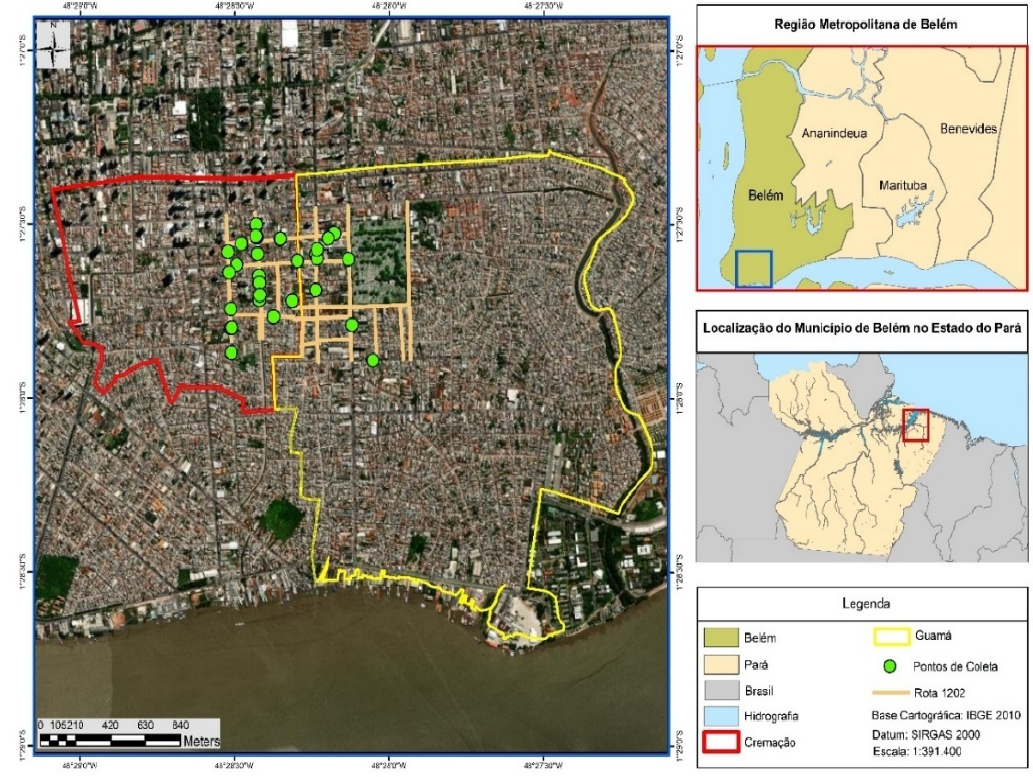
Figure 2. Collecting points (green circles) of municipal household solid waste (MHSW) in the neighborhoods of Cremação and Guamá in the city of Belém-Pará-Brazil on 18 October 2021, 20 October